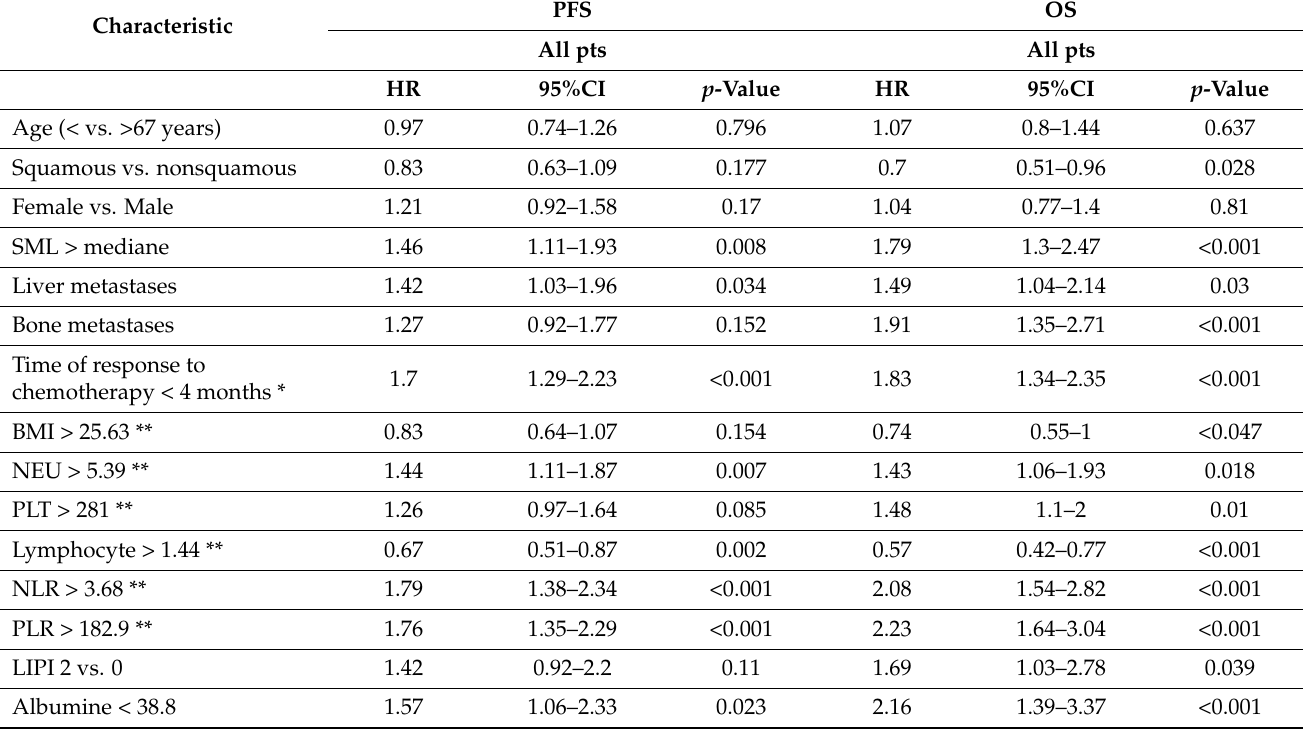
Table 4. Univariate analysis for all